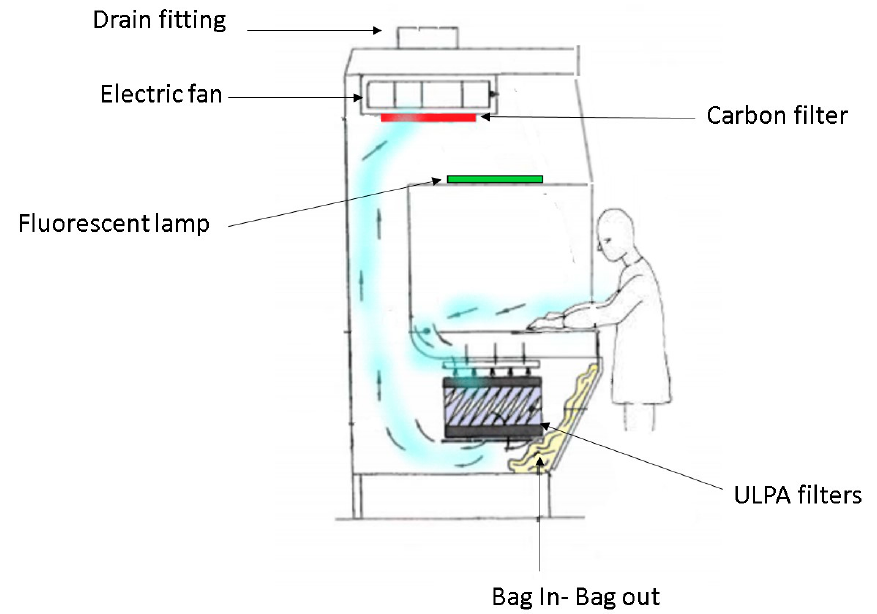
Figure 1. Schematic and section side view of the laboratory extraction hood comprising the filtering and safety removal kit.